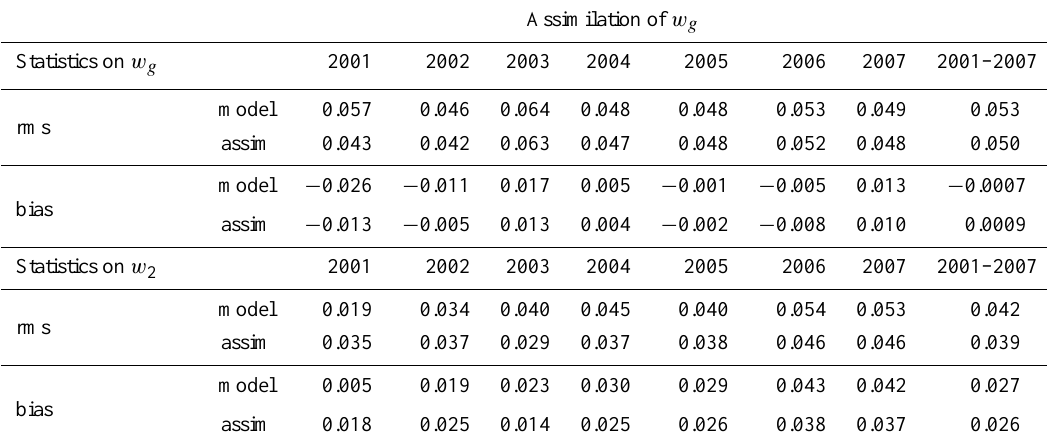
Table 5. Statistics on w g and w 2 (m 3 m − 3 ) before and after assimilation of surface soil moisture w g , year by year and for the 7-year period